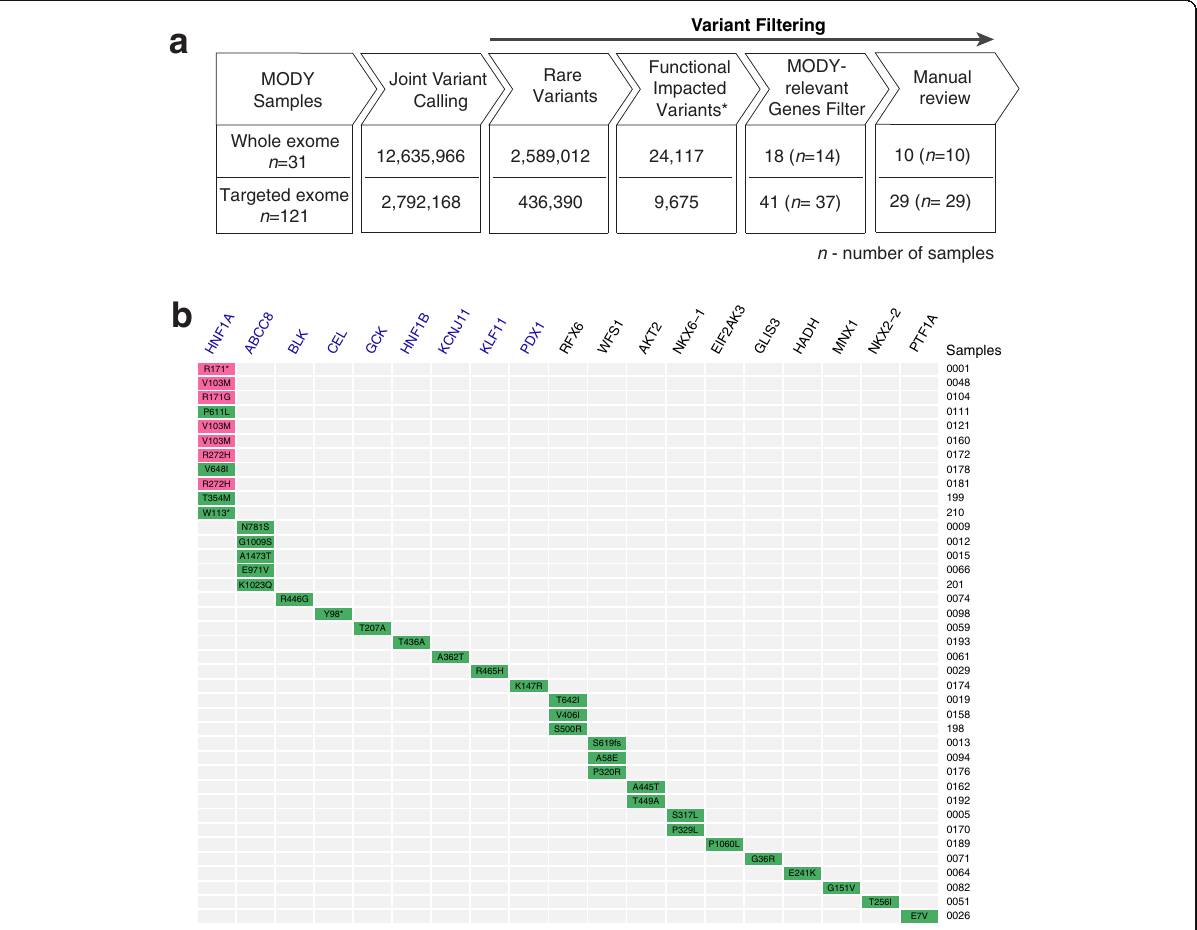
Fig. 2 MODY relevant variant identification. a Schematic representation of the steps involved in MODY relevant variant identification; * indicates variants that are protein-altering or potentially protein-altering. b MODY relevant variants identified in indicated genes for each patient sample. Pink indicates variants previously reported, green indicates novel or ultra-rare